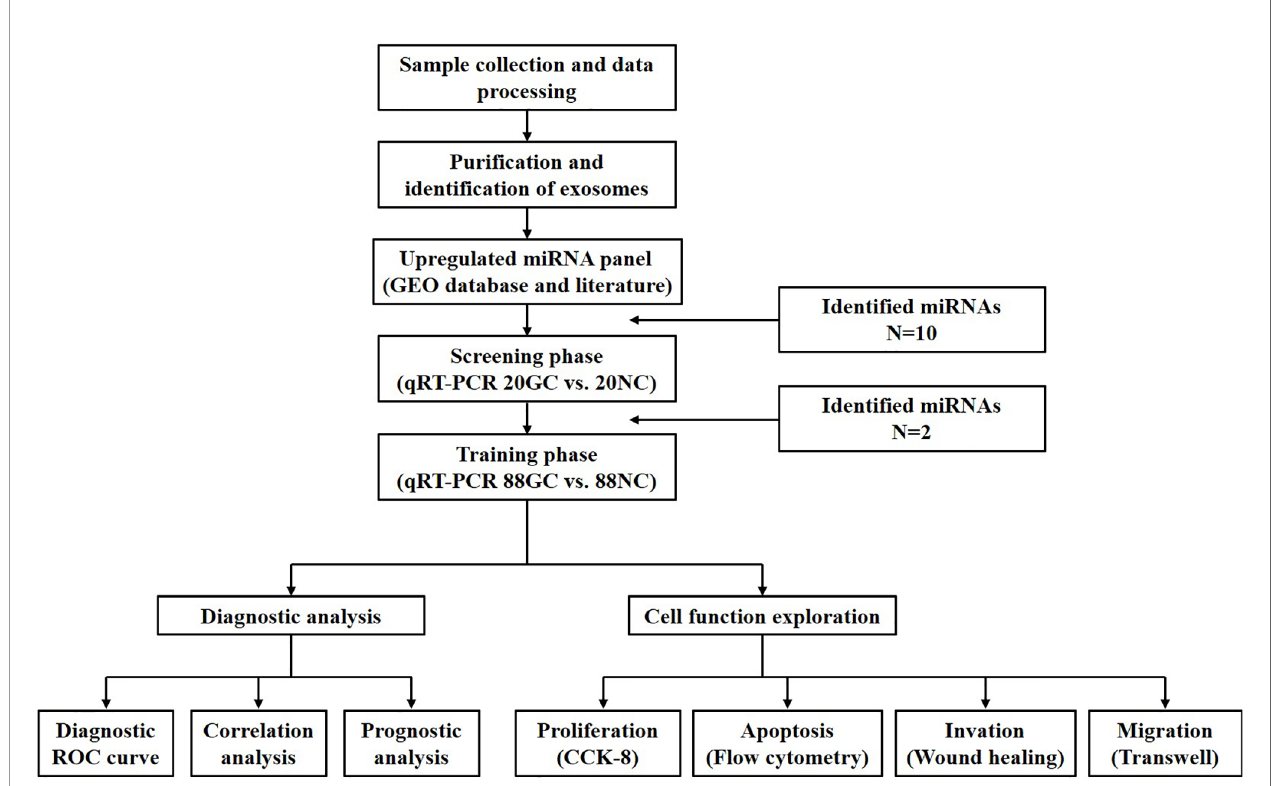
FIGURE 1 | Study design and strategy depicted in the above schematic diagram. There were 2 phases of the study, all involving the use of plasma